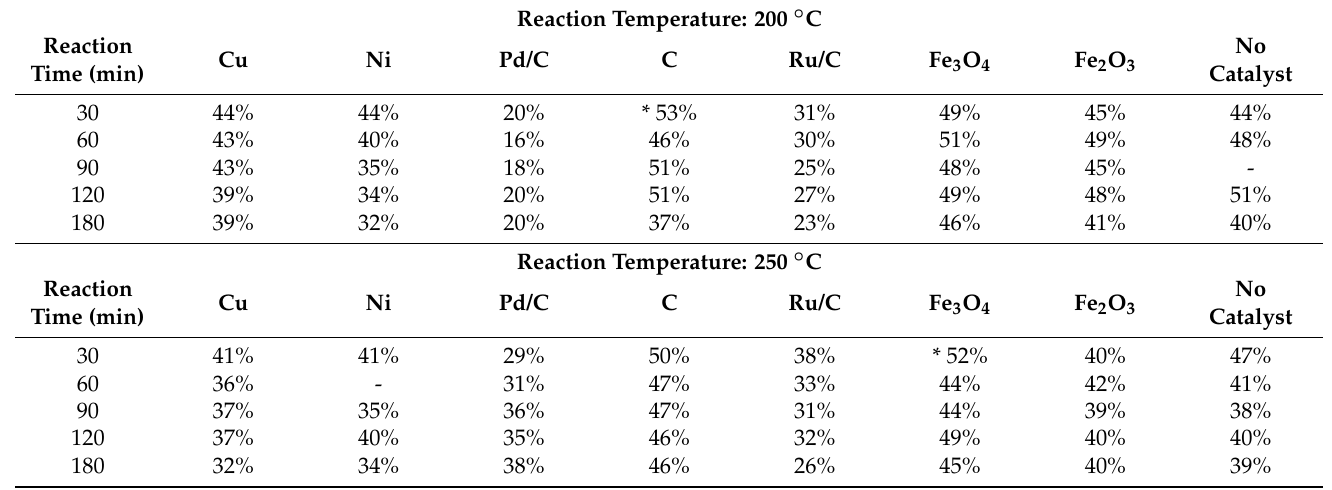
Table 1. Yields of formic acid obtained after the hydrothermal reaction of NaHCO 3 with glucose in the presence of catalysts. The higher yields obtained after the hydrothermal reactions are marked with an asterisk (*).